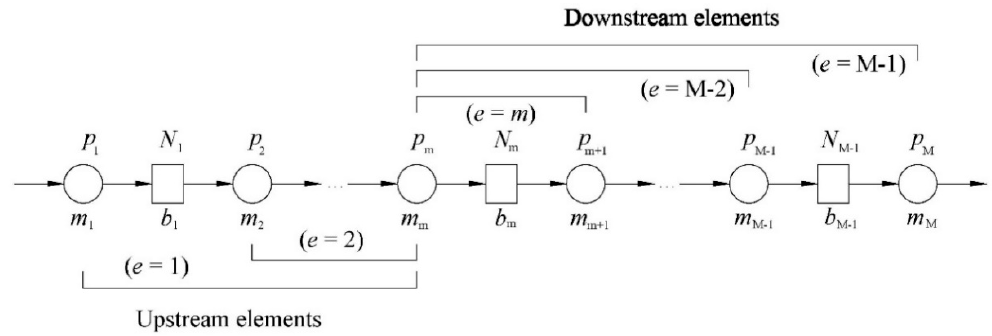
Figure 3. A general case of the serial Bernoulli production line and finite state elements (authors’